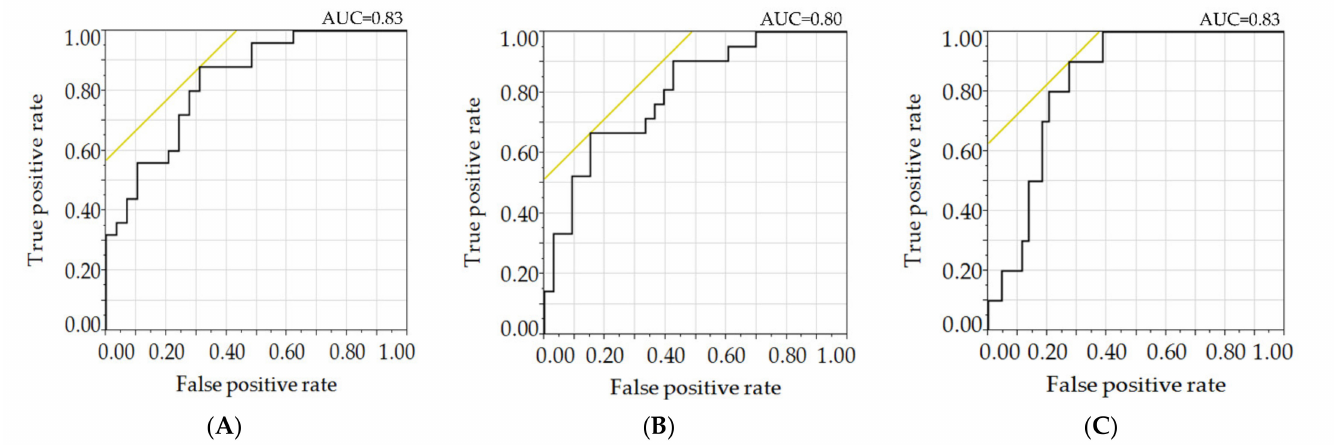
Figure 3. ROC curves for various NCS parameters stratified by the thresholds identified for prediction of incident DSP. ( A ) Peroneal CV, ( B ) peroneal F-wave, ( C ) tibial F-wave. ROC, receiver operating characteristic; AUC, area under the curve; F-wave, F-wave latency. NCV parameters were stratified by the thresholds identified for the prediction of incident DSP according to a previous report as described in the “ Patients and Methods ” section, that is, the thresholds for peroneal conduction velocity, peroneal F-wave, and tibial F-wave were 42.4 m/s, 51.8 ms, and 57.6 ms,